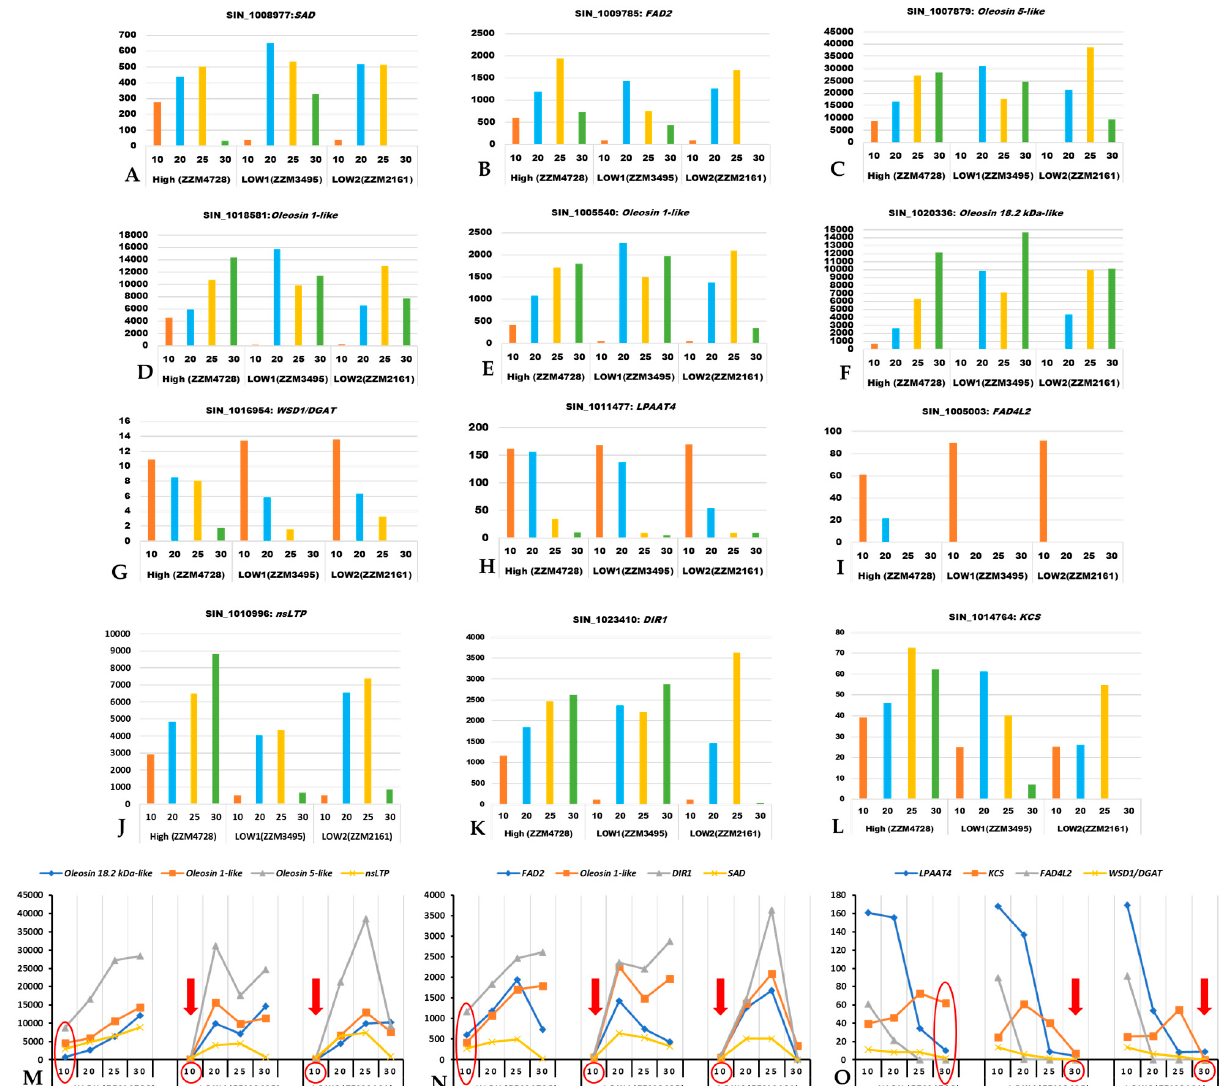
Figure 5. Expression profiles (in FPKM values, Y-axis) for key regulatory genes of oil biosynthesis in sesame using the transcriptome dataset of Wang et al. (2019). The X-axis represents the developmental stages in days post anthesis (DPA). ( A ): Sad ; ( B ): Fad2 ; ( C ): Oleosin 5-like ; ( D ): Oleosin 1-like ; ( E ): Oleosin 1-like ; ( F ): Oleosin 18.2 kDa-like ; ( G ): Dgat ; ( H ): Lpaat4 ; ( I ): Fad4L2 ; ( J ): nsLTP ; ( K ): DIR1 ; ( L ): KCS ; ( M , N ): Set of genes that are expressed significantly less at 10 DPA in both of the low oil yielding genotypes (indicated with a red colored down arrow at 10 DPA); ( O ): Set of genes that are significantly less expressed at 30 DPA in both of the low oil yielding genotypes (indicated with a red colored down arrow at 30 DPA).